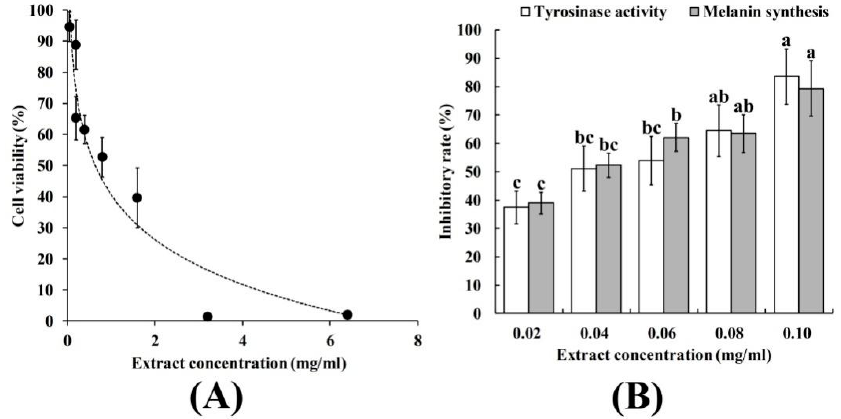
Figure 4. The effect of SIFs extract on cell activity ( A ) and inhibition rate of tyrosinase and melanin synthesis in melanoma cells A375 ( B ). Different small letters mean significant differences at p < 0.05.